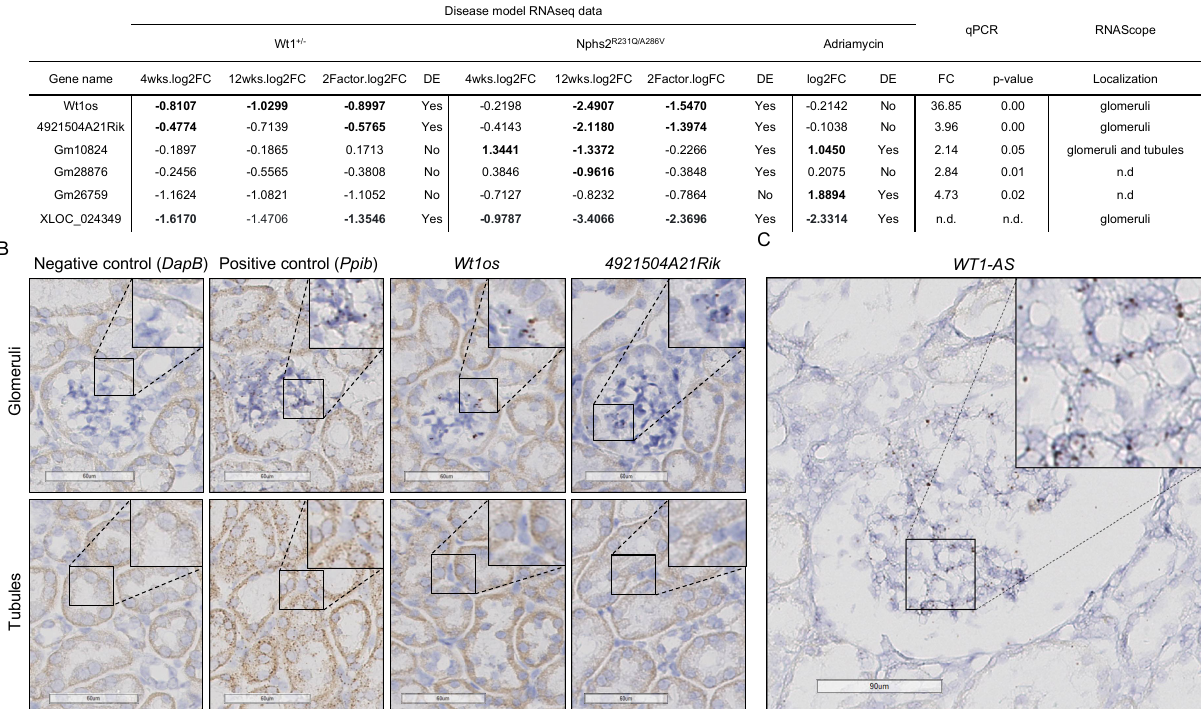
Figure 4. The qPCR and RNAscope validate podocyte-specific lncRNAs as defined by CALINCA. A) Table showing six lncRNAs dysregulated in at least one of the FSGS models, the glomerular expression which was validated by qPCR and/or RNAscope. Regarding Wt1 +/− and Pod R231Q/A286V models, a transcript is classified as differentially expressed (DE/Yes) if it is significantly regulated (adjusted p -value < 0.05) in at least one of the time points (4 weeks, 12 weeks) or in the two-factor model. The same cutoffs apply for the Adriamycin model with a one-time point only. For the full table, refer to Supplementary Table S1 or calinca.dieterichlab.org. ( A ) Visualization of the qPCR data is provided in Supplementary Figure S2. ( B ) Representative images of glomeruli and tubules analyzed with custom designed RNAscope probes for lncRNAs Wt1os and 4921504A21Rik. Both lncRNAs are specifically detected in glomerular cells only, whilst the positive control shows a signal in both glomeruli and tubuli. Additional images as well as the results for Gm10824 and XLOC_024349 are provided in Supplementary Figure S3. Target lncRNAs and controls were detected with the RNAscope 2.5 HD—brown assay on FFPE mouse kidney tissue sections. Probe binding is visualized as punctate brown dots. Counterstain: Hematoxylin (blue). Scale bar: 60 µm. ( C ) The human ortholog of Wt1os (WT1-AS) is expressed in glomerular cells. Representative image of a human glomerulus analyzed with a custom designed RNAscope probe for WT1-AS. The lncRNA was detected with the RNAscope 2.5 HD—brown assay on a formalin-fixed, paraffin-embedded (FFPE) human kidney tissue section. Probe binding is visualized as punctate brown dots. Counterstain: Hematoxylin (blue). Scale bar: 90 µm. More images as well as the images showing lack of expression in tubuli are provided in Supplementary Figure S4.